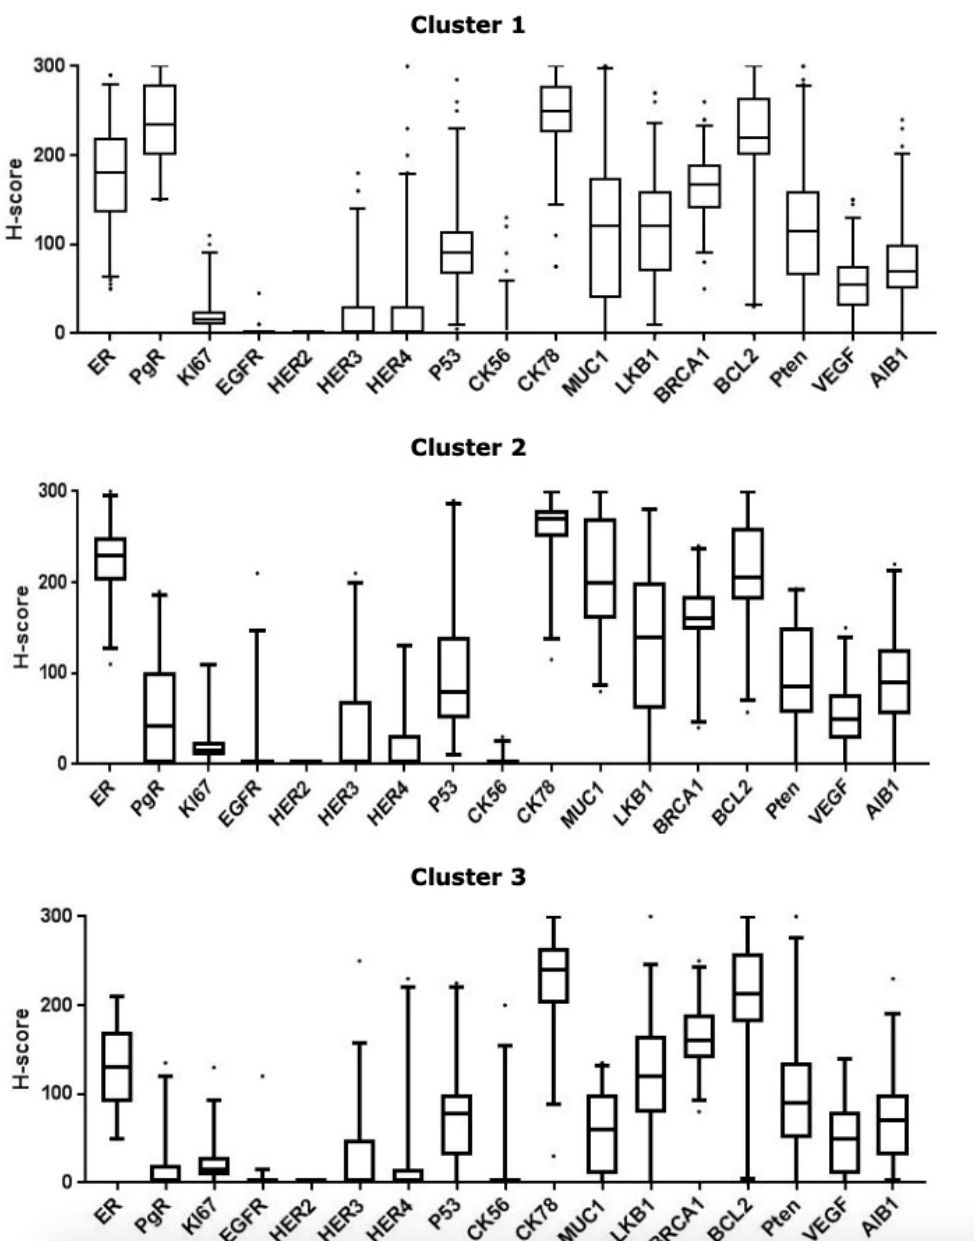
Figure 1. Boxplots used to define patterns of ER-positive early operable primary breast cancer in older women, demonstrating 3 clusters including 17 biomarkers. The middle line within each box indicates median expression whilst outliers are indicated using